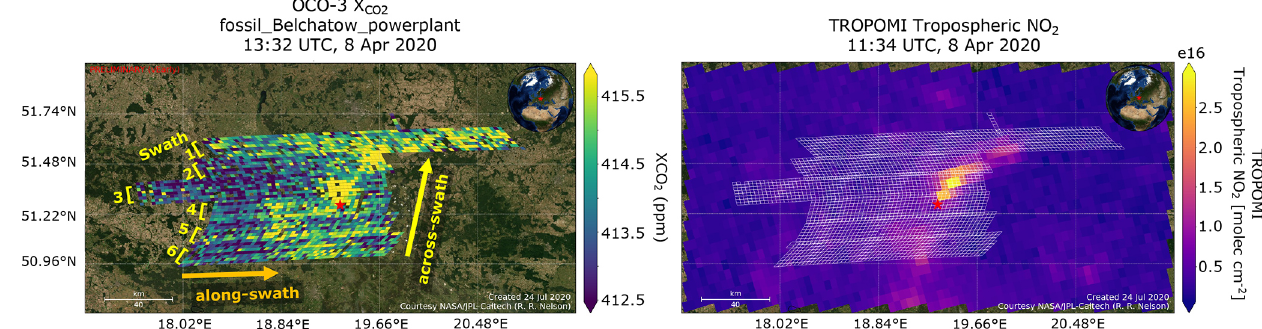
Figure 1. OCO-3 vEarly SAM showing observed X CO enhancements compared to coincident TROPOMI NO 2 data over the Bełchatów 2 power station in Poland. We have identified individual swaths using brackets; the along-swath and across-swath dimensions, which we will refer to repeatedly in this work, are designated by the colored arrows.